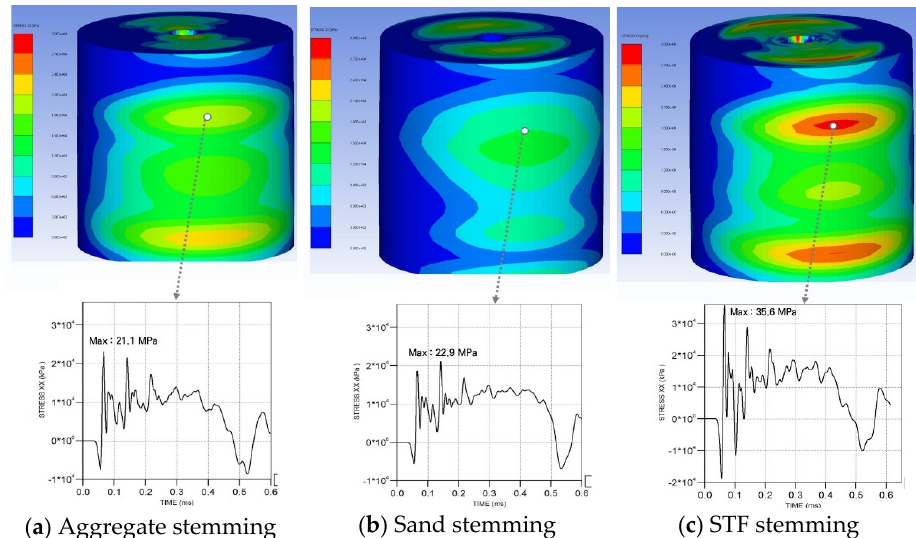
Figure 21. Stress ( σχχ ) contour on the surface of the lead block at 0.2 ms after blasting and the time– stress curve at the specified